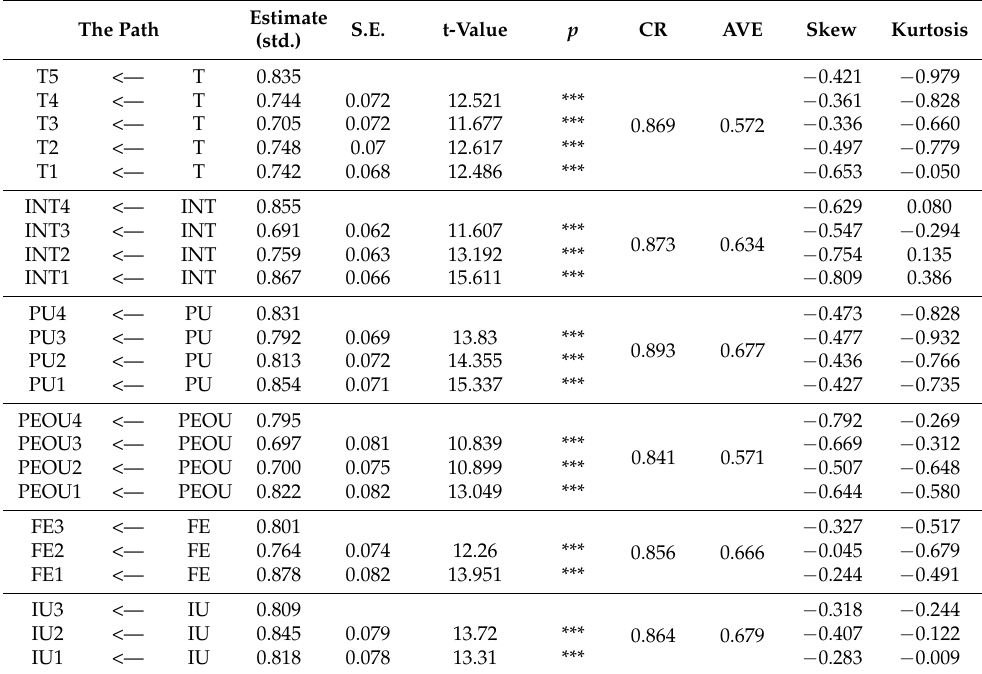
Table 4. Confirmatory factory analysis of the study.